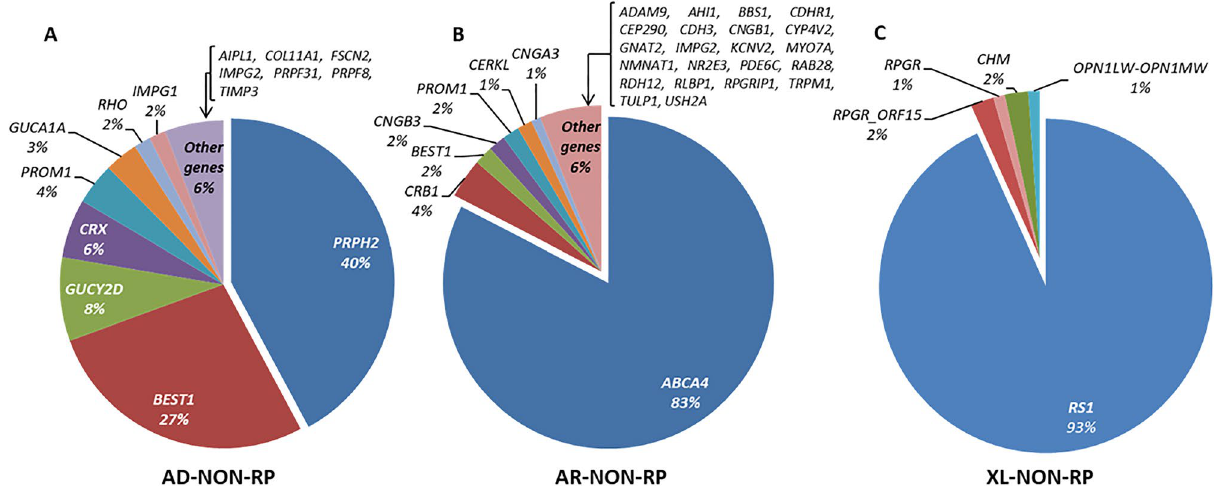
Figure 3. Classification of mutated genes in the genetically solved NON-RP affected cases. Below each gene is given the percentage that each gene was mutated in the cohort. Total characterized families: AD-NON-RP: 121; AR-NON-RP: 544; XL-NON-RP: